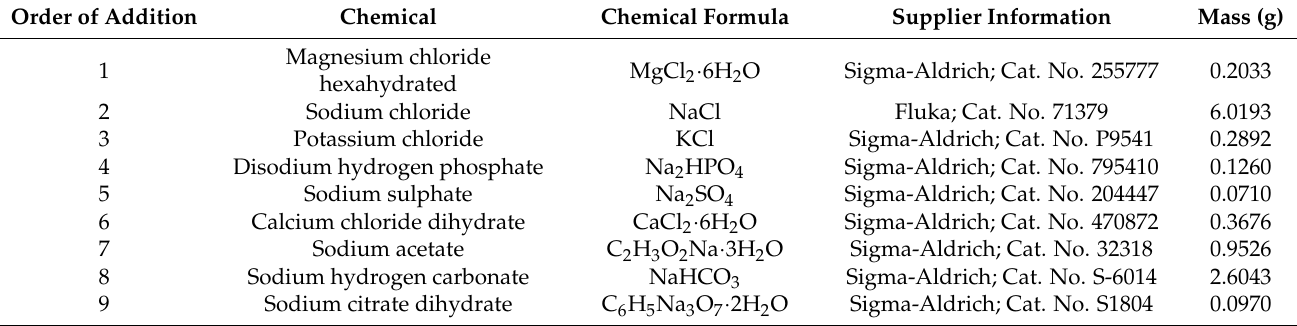
Table 1. Composition (g/L) of Gamble solution (modified according to Stopford et al., 2003, and Midander et al.,